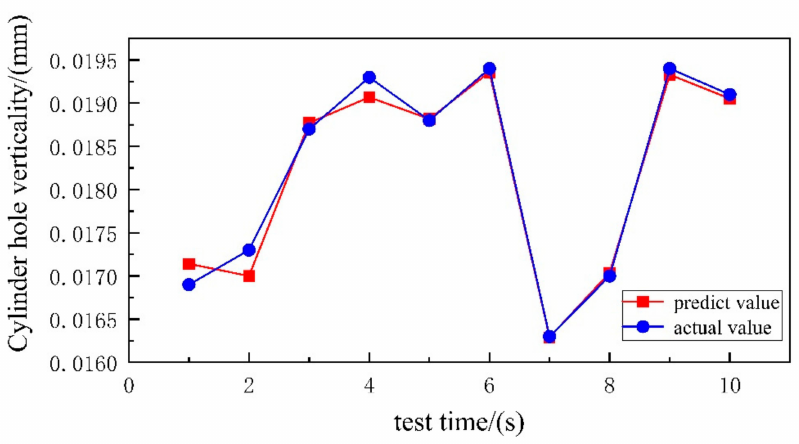
Figure 9. Cylinder bore verticality prediction